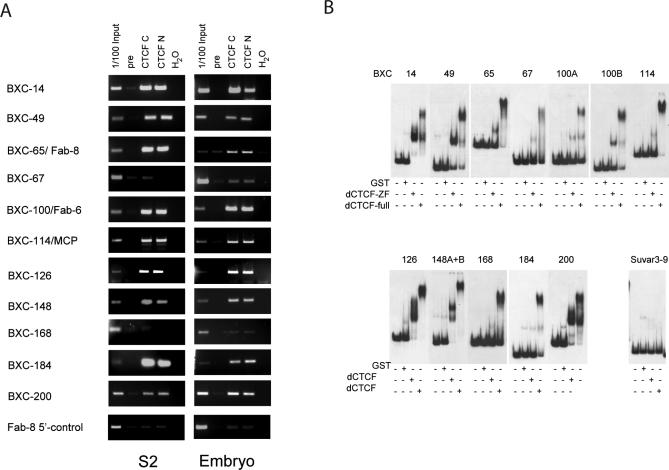
Validation of CTCF Sites by ChIP and In Vitro Binding(A) ChIP was performed with chromatin from Drosophila Schneider cell line 2 (S2) cells and from embryos. Fragments are numbered according to coordinates from the original Drosophila Genome Project sequencing of the BX-C (see Figure 2) [20]. CTCF-specific antibodies (C- or N-terminal specific) immunopurify the same set of CTCF binding sites as were enriched in the ChIP-array. Negative controls were pre-immune serum or a nonbinding sequence (Fab-8 5′-control). BXC-67 and 168 show very weak, if any, enrichment.(B) In vitro binding assays (EMSA) show direct binding of CTCF to predicted CTCF sites in the BX-C. Radioactively labelled probes were incubated with GST, GST-CTCF-ZF, or GST-CTCF full length. All predicted sites are bound. A negative control sequence from the Su(var)3–9 gene does not bind to CTCF.